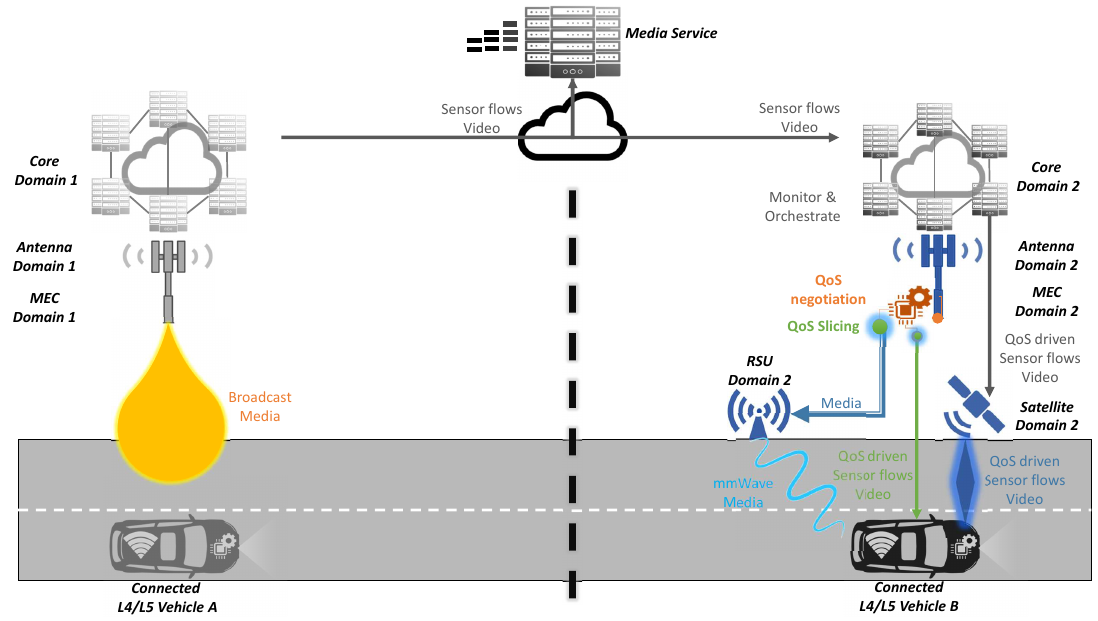
Figure 8. Quality of experience scenario of the proposed